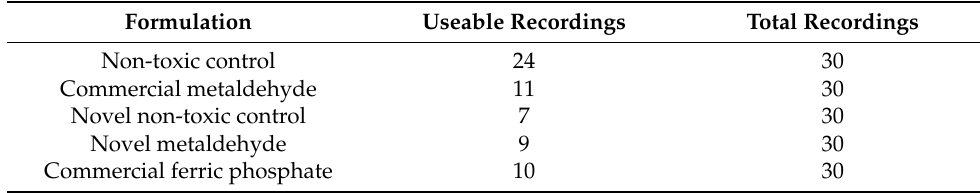
Table 2. Number of useable and total bioacoustics recordings in laboratory trials.